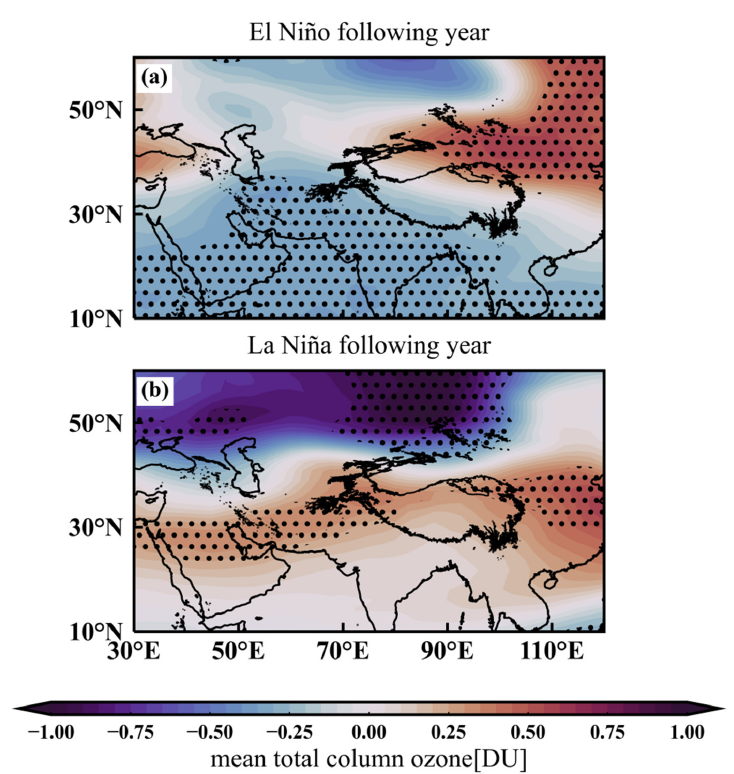
Figure 8. Simulation results of composite O 3 anomalies in the summers following El Niño and La Niña (unit: DU). ( a ) El Niño, ( b ) La Niña. The black-dotted regions are statistically significant at the 95% confidence level ( t -test).